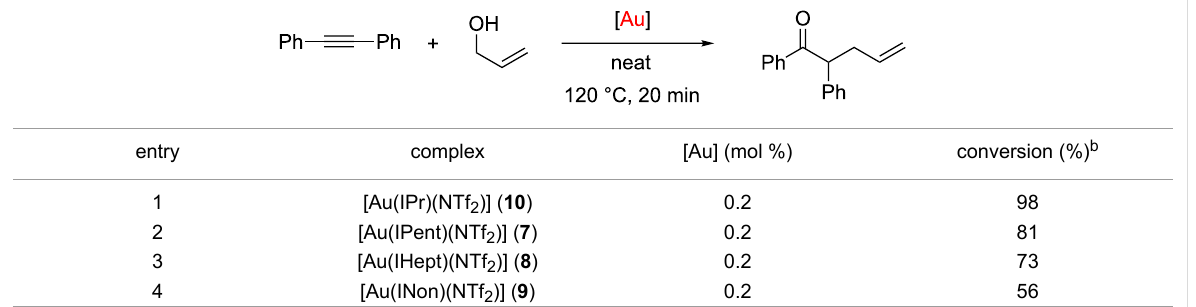
entry complex [Au] (mol %) conversion (%) b